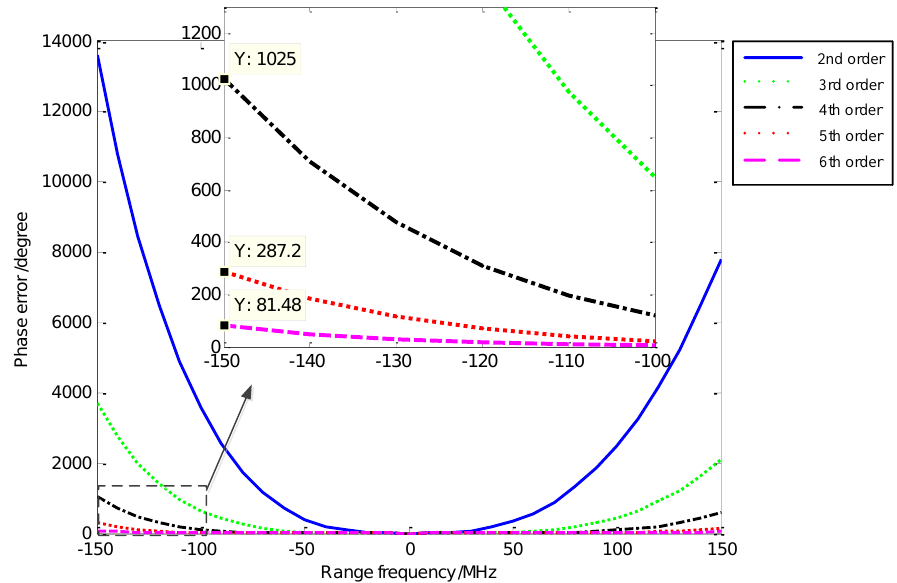
Figure 1. Phase errors of 2nd to 6th order Taylor series approximation. The point target at a range of 12 km with a center frequency of 600 MHz, a bandwidth of 300 MHz and a beamwidth of 29 ◦